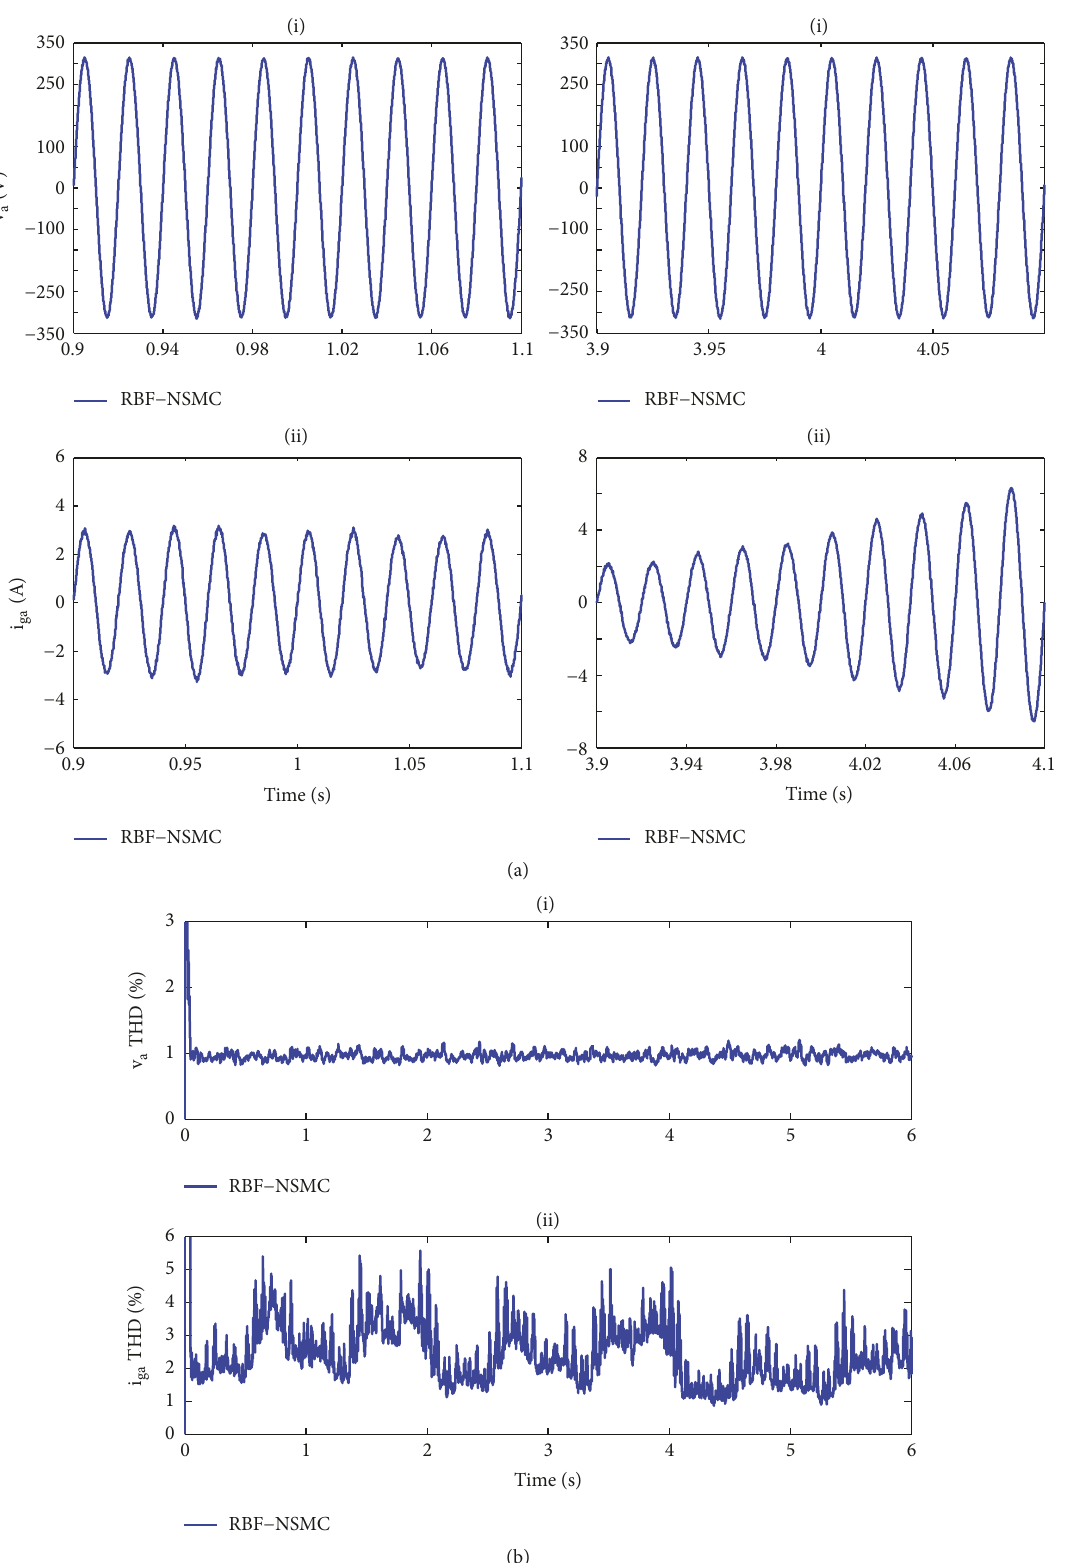
Figure 12: Control system response to wind speed fluctuations with parameters uncertainties (at time 𝑡 = 1𝑠 , variations of +100 % for 𝑅 𝑠 , +50 % for 𝐿 −20 % for 𝜙 +30 % for 𝐽 are introduced). (a) Zoom on LCL filter capacitor voltage and injected grid current trajectories 𝑠 , 𝑟 , and with (b) corresponding THD behaviours. (i) Filter capacitor phase −𝑎 voltage; (ii) injected grid phase −𝑎